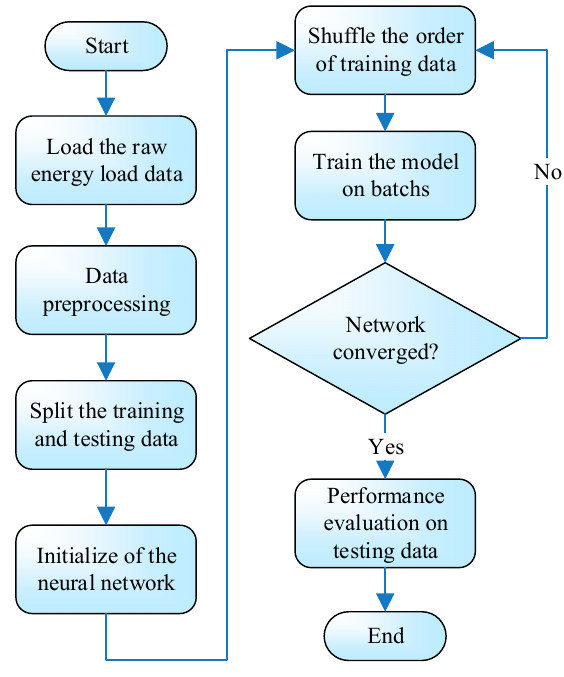
Figure 5. The DeepEnergy flowchart.